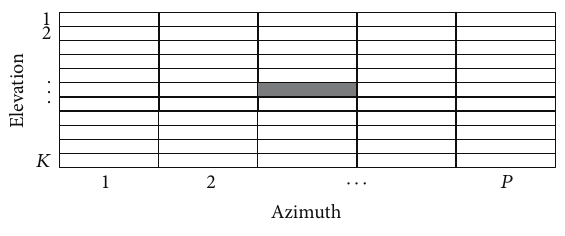
Figure 1: Antenna architecture of HRWS